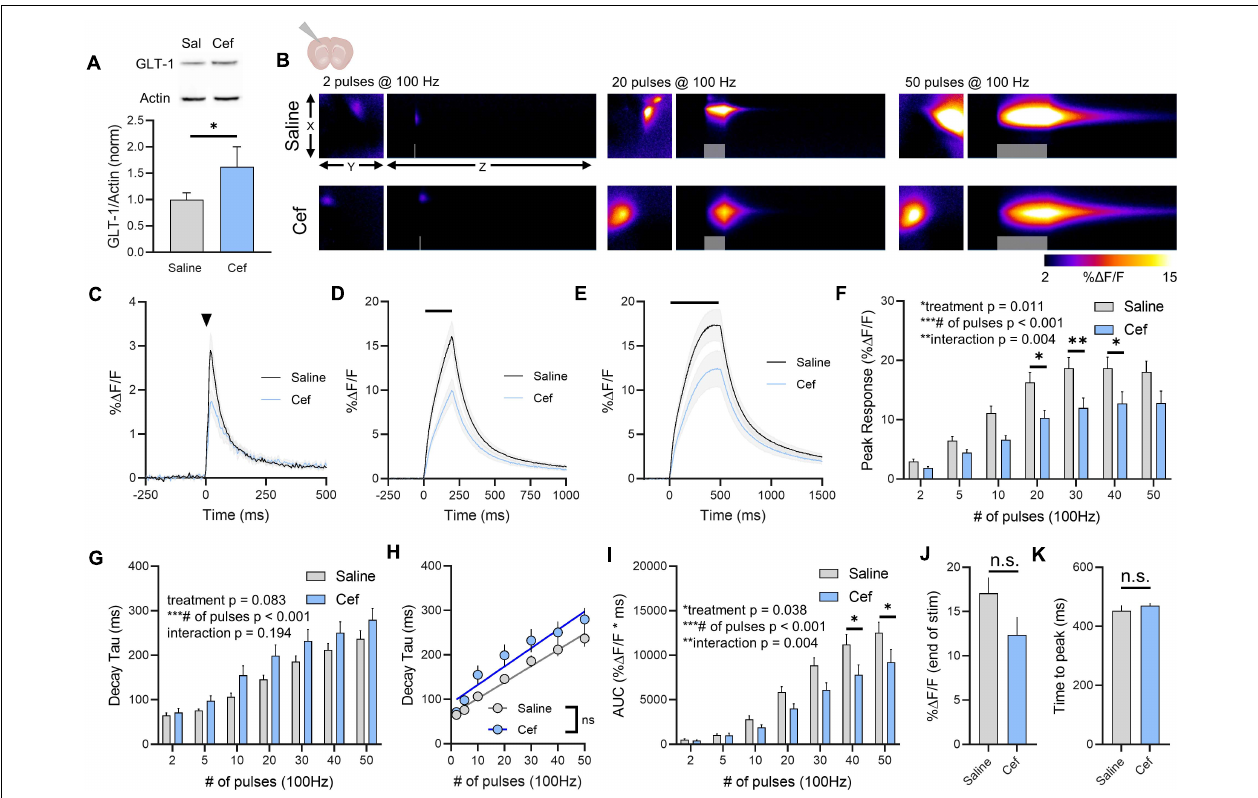
FIGURE 2 | The effect of ceftriaxone on glutamate dynamics in the cortex. (A) GLT-1 expression in cortical tissue from saline and ceftriaxone (Cef)-treated mice. (B) Representative images depicting the iGluSnFR response evoked by 2 (left), 20 (middle), and 50 (right) pulses of electrical stimulation at 100 Hz in saline- (top) and Cef-treated (bottom) mice. X–Y images (2048 × 2048 µ m) depict the maximal projection image of the iGluSnFR response, while the X–Z image (2048 µ m vertically x 1945 ms horizontally) depicts the iGluSnFR response over time (z-axis). Gray shading indicates the onset and duration of electrical stimulation at 100 Hz. (C–E) Mean ( ± S.E.M in gray) iGluSnFR responses to 2 (C) , 20 (D) , and 50 (E) pulses at 100 Hz in saline- and Cef-treated mice. Electrical stimulation is denoted by the arrowhead in (C) and the horizontal lines in (D) and (E) . (F) Mean ( ± S.E.M) iGluSnFR response peaks. (G) Mean ( ± S.E.M) iGluSnFR decay tau values. (H) Linear regression to assess the magnitude of the activity-dependent increase in iGluSnFR decay tau. (I) Mean ( ± S.E.M) iGluSnFR area under the curve (AUC). (J) Mean ( ± S.E.M) of the iGluSnFR response size (% (cid:49) F/F) at the termination of the 50-pulse stimulation paradigm (50 pulses at 100 Hz). (K) Mean ( ± S.E.M) of the time required for the iGluSnFR response to reach a peak during the 50-pulse stimulation paradigm. Sidak’s multiple comparisons post hoc test was used in (F) and (I) . ∗ p < 0.05, ∗∗ p < 0.01, ∗∗∗ p < 0.001. n.s. not significant. Brain slice schematic in (B) was created using